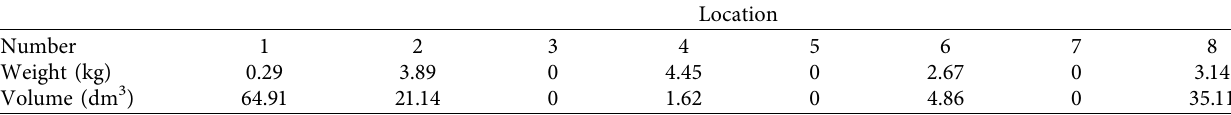
Table 6: UAV payload surplus.